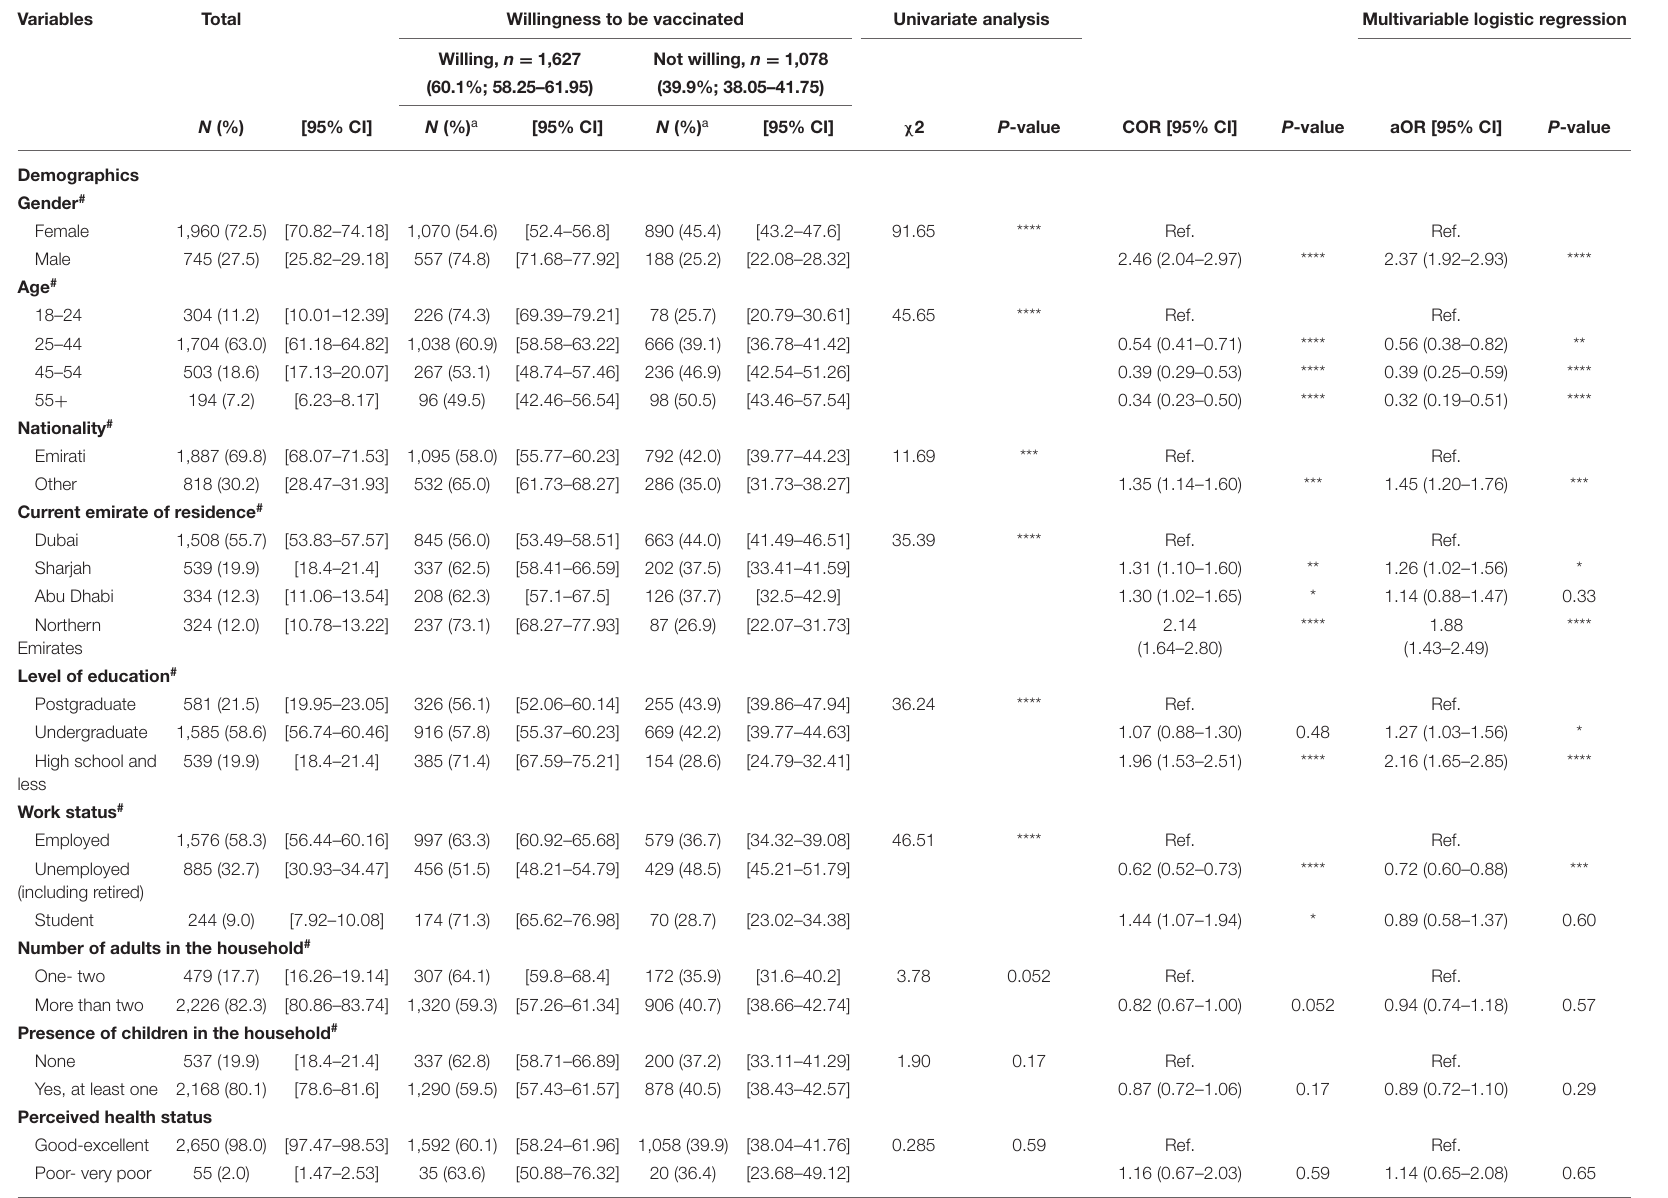
TABLE 1 | Sociodemographic characteristics, COVID-19 and vaccination perceptions of study participants and their associations with the willingness to take COVID-19 vaccine in the future ( n = 2,705). Variables Total Willingness to be vaccinated Univariate analysis Multivariable logistic